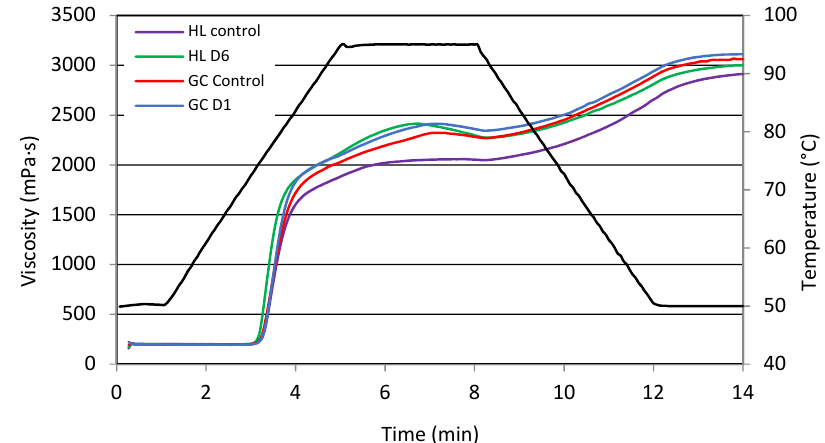
Figure 1. Pasting curves of selected potato starches.